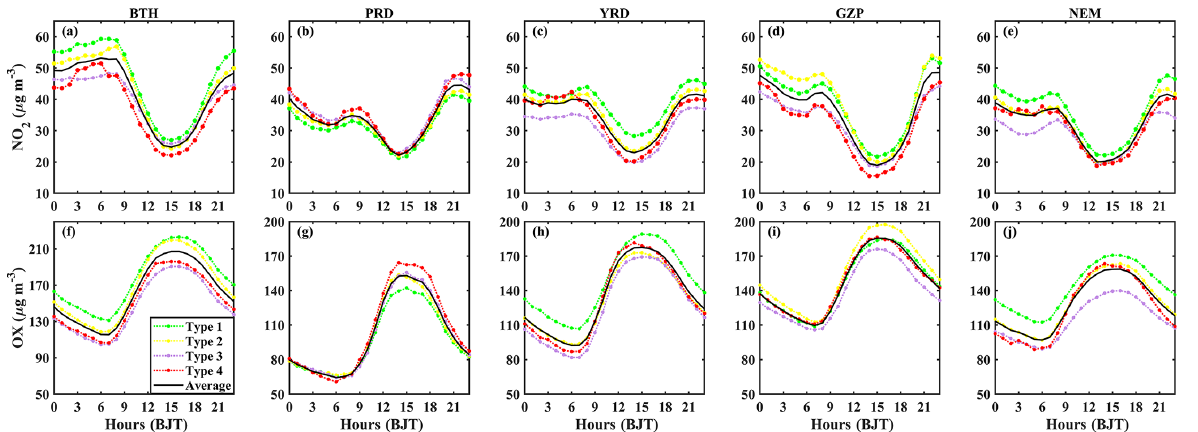
Figure 10. Daily variations of NO 2 (a–e) and OX (f–j) under four SWPs in key urban